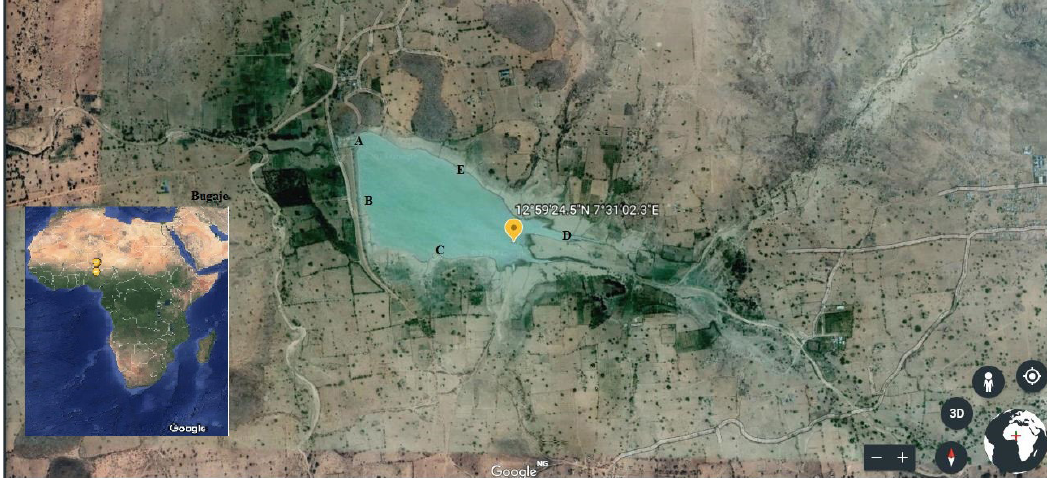
Figure 1. Map of the Study Area Showing the Sampling Sites A, B, C, D and E (Source: Google